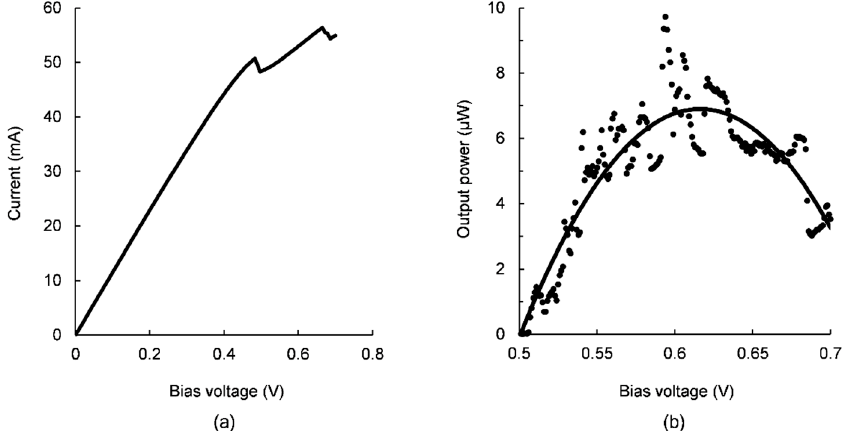
Figure 3. ( a ) Measured I–V curve of the RTD chip used for this experiment. The chip includes a stabilization resistor connected in parallel with the RTD, as shown in Figure 2c, which explains the difference from the typical I–V curve around the NDC region. ( b ) The dependence of the RTD output power on the bias voltage; dots: measured data; solid line: data smoothed to show the average trend. The large fluctuations are due to terahertz radiation coming back to the RTD and affecting its oscillation frequency. The strongest carrier power, almost 10 µW, is obtained at a bias voltage of around 0.60 V, but the amplitude modulation is the most efficient at 0.56 V.